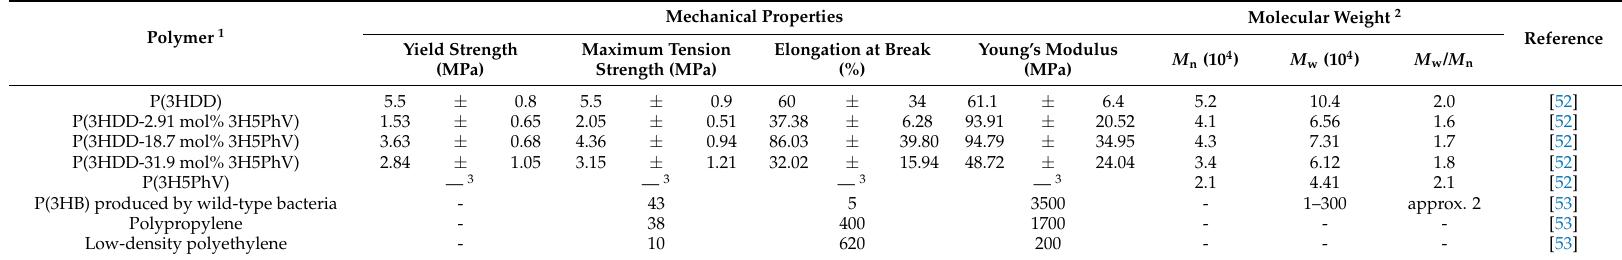
Table 2. Mechanical properties of P(3HDD-3H5PhV) with various 3H5PhV